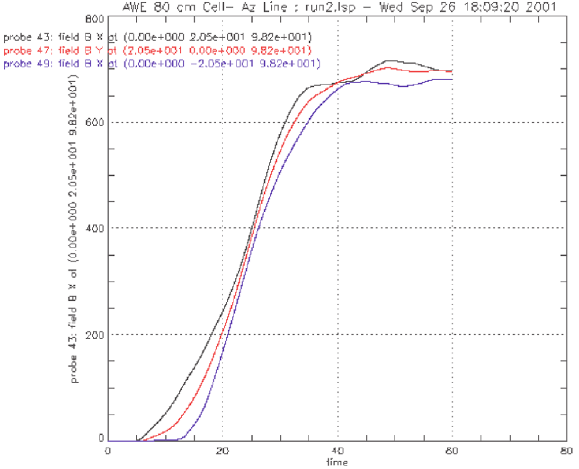
FIG. 23. (Color) B in MITL measured 7 cm beyond anode plate.